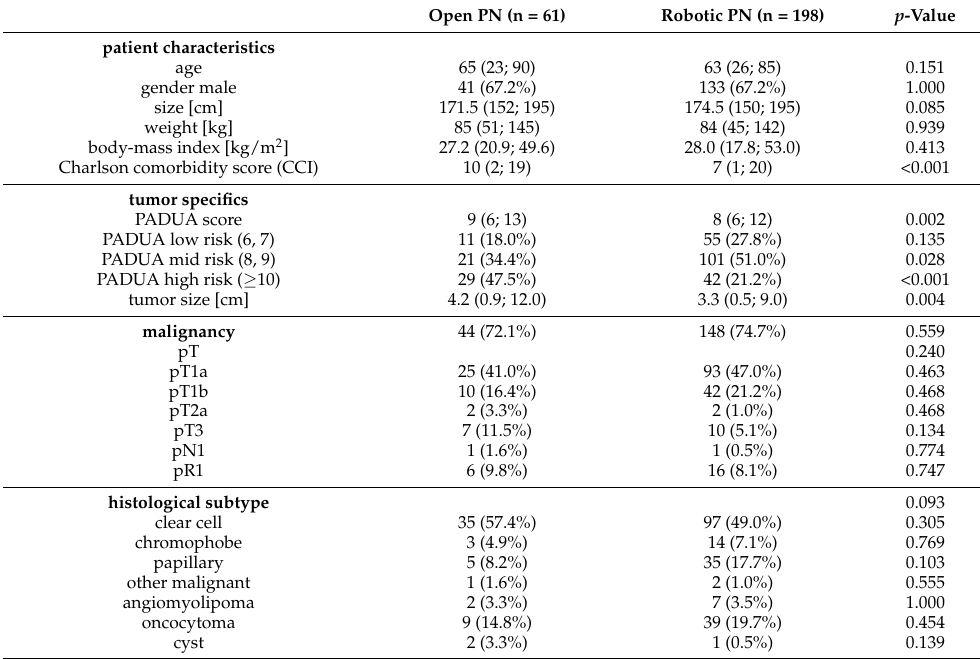
Table 1. Comparison of patient and tumor characteristics and the histopathological results of open vs. robot-assisted partial nephrectomies (PN) in the overall analysis. Open PN (n = 61) p